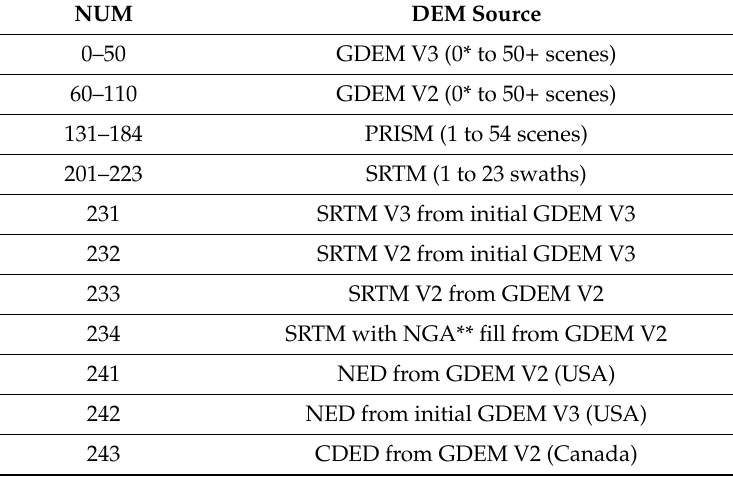
Table 3. Contents of NUM file showing number of DEM tiles used, and source of void